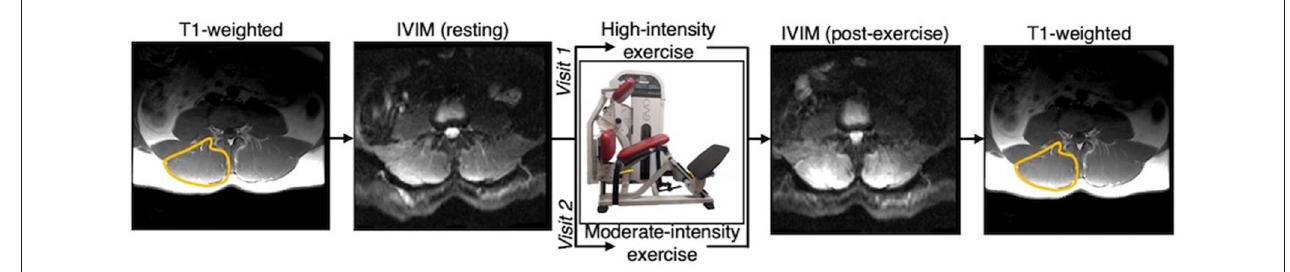
FIGURE 1 | Overview of experimental design. Participants were scanned at rest and following either a moderate or high intensity resisted lumbar extension exercise paradigm. Moderate and high intensity exercise sessions were performed on two separate days. T1-weighted anatomical reference images were acquired before and after the pre- and post-exercise IVIM data, respectively, and used to define the paraspinal muscles